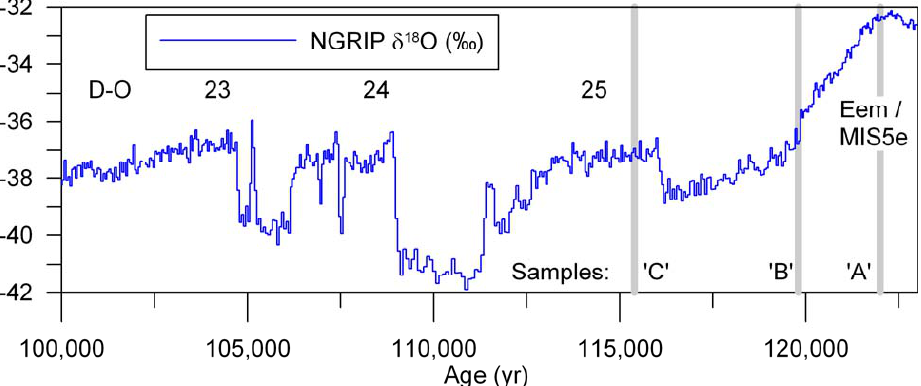
Fig. 1. The NGRIP δ 18 O profile with indication of Dansgaard-Oeschger events (D-O) and the sampled ice core sections. The three 2.2m sample sections are taken at the depths indicated by the gray vertical lines. The samples are referred to as “A”, “B”, and “C” as indicated. See Table 1 for further sample